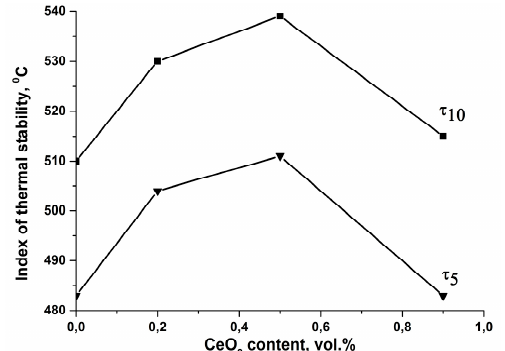
Figure 2. Thermal stability indices τ 5 and τ 10 of the DPhO-BAPS-CeO 2 nanocomposites with various content of the nanofiller.